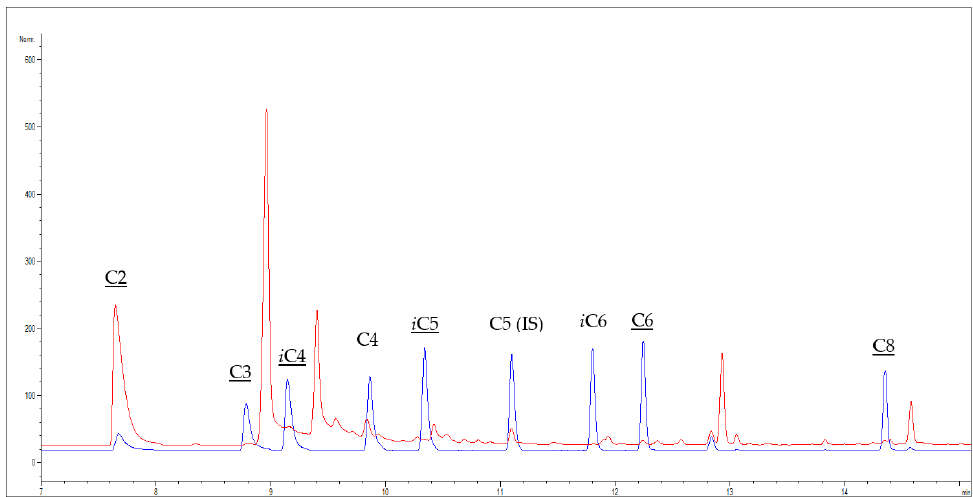
Figure 1. Overlapped chromatograms obtained from GC-FID analysis of a red wine sample (Nero D’Avola) containing the internal standard (IS) (red chromatogram) and a standard mixture containing SCFAs and MCFAs C2-C8 at 0.1 g L − 1 (blue chromatogram). Underlined shorthand names indicate analytes that can be quantified by the present method.